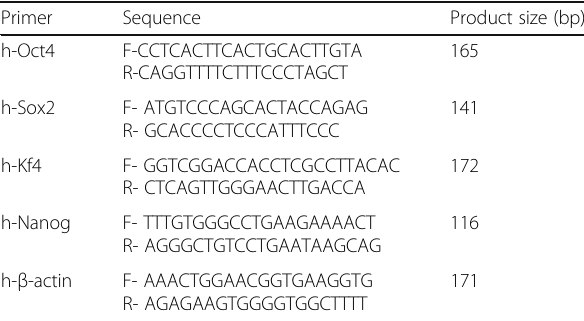
Table 1 List of the primers used in this